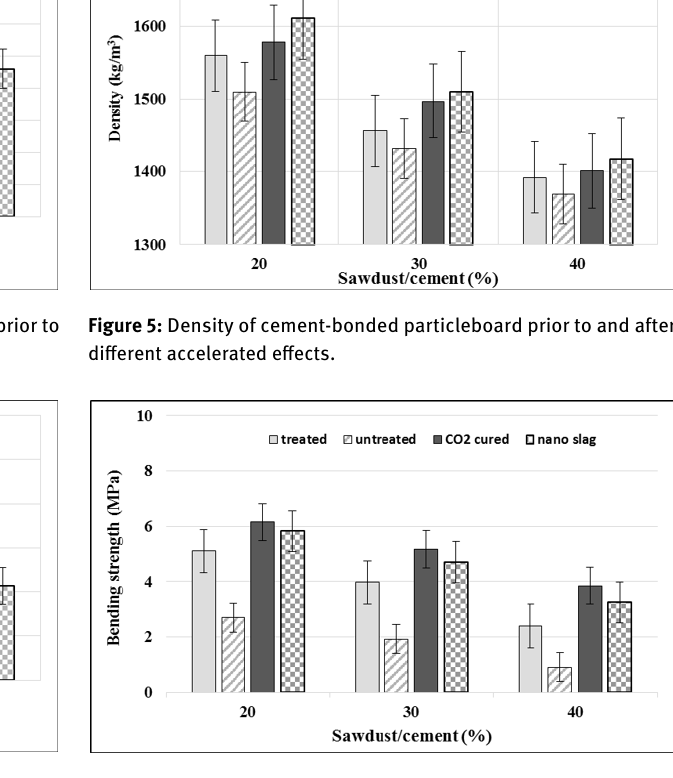
Figure 6: Bending strength of cement-bonded particleboard prior to and after different accelerated